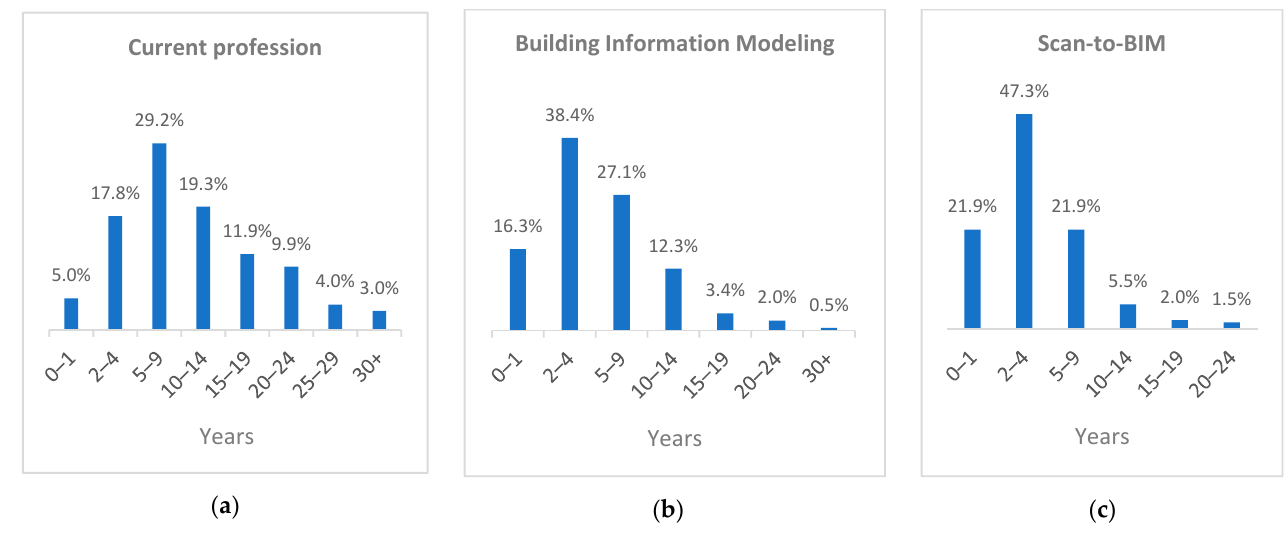
Figure 7. Participant’s years of professional experience. ( a ) How many years practicing in their current profession. ( b ) How many years working with building information modeling (BIM) methodology, ( c ) How many years working with scan-to-BIM projects.